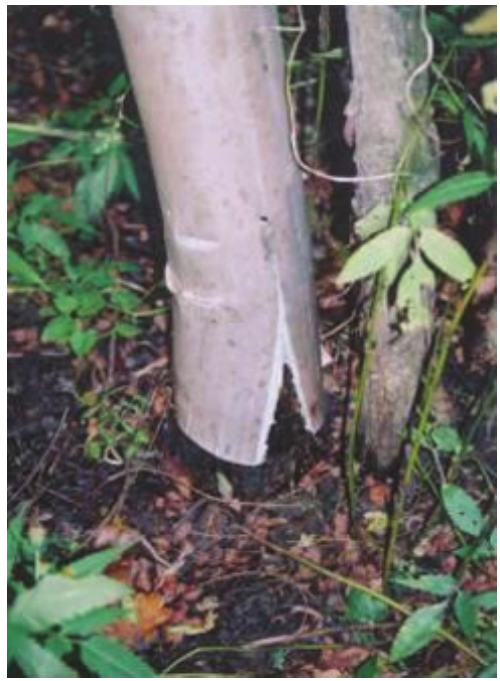
FIGURE 3 . A polypropylene tree shelter without a weakening line (August